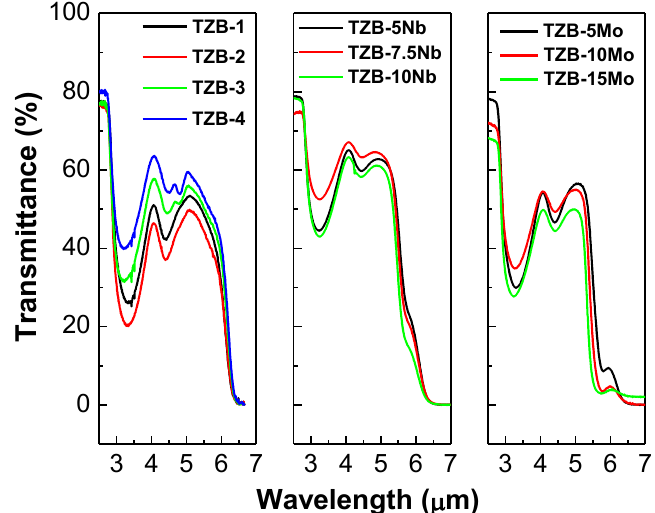
Figure 3. Mid-infrared (IR) transmission spectra of TeO 2 − BaO − ZnO glasses varied with di ff erent additive concentrations.